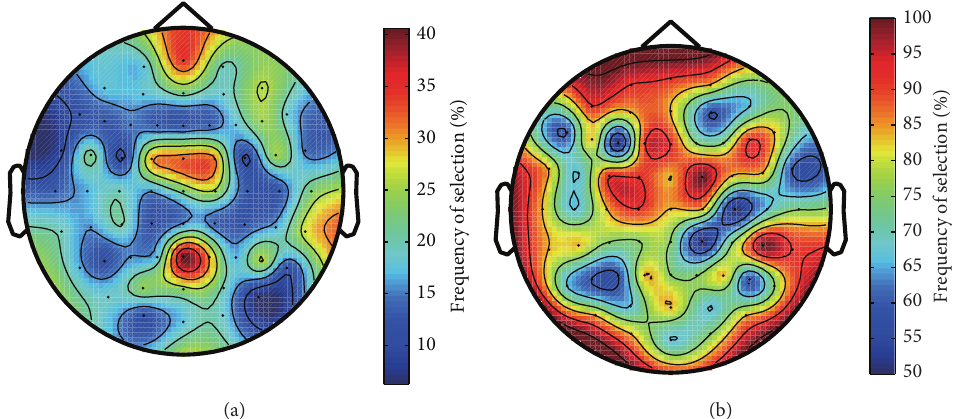
Figure 5: Frequency of selection of channels in (a) the proposed algorithm (across all MHPSO cases and subjects) and (b) SWLDA (across all subjects). Note that the color gradations denote different ranges in each